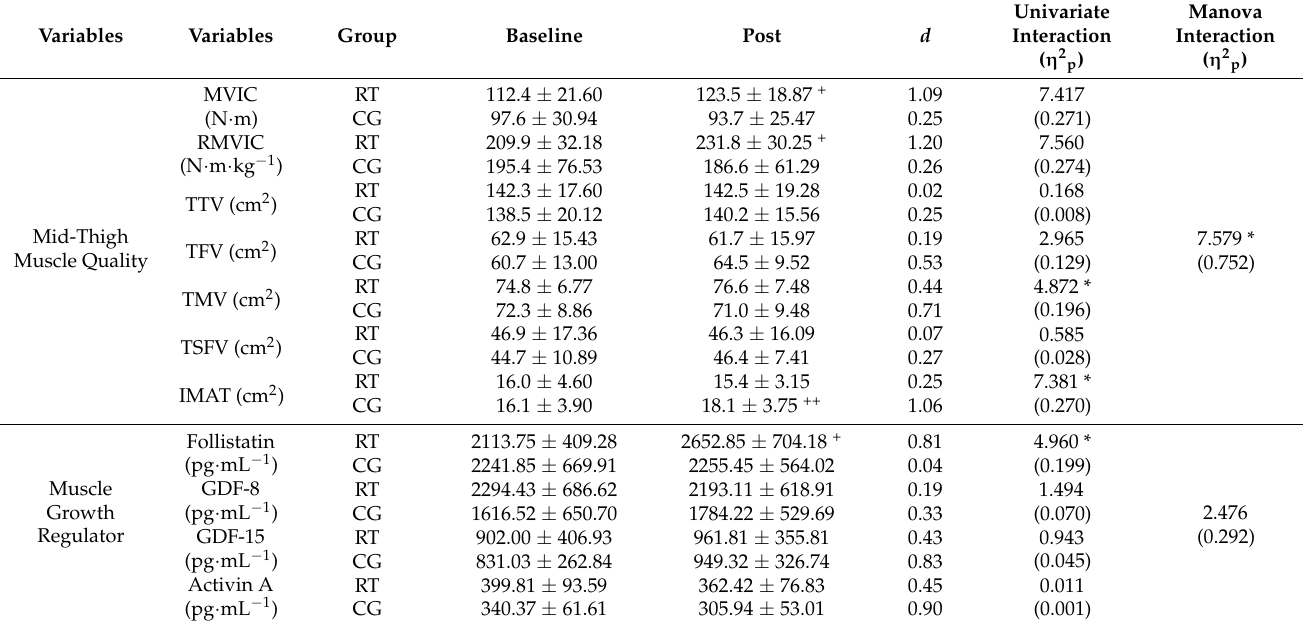
Table 6. Change in muscle quality and muscle growth regulators during the